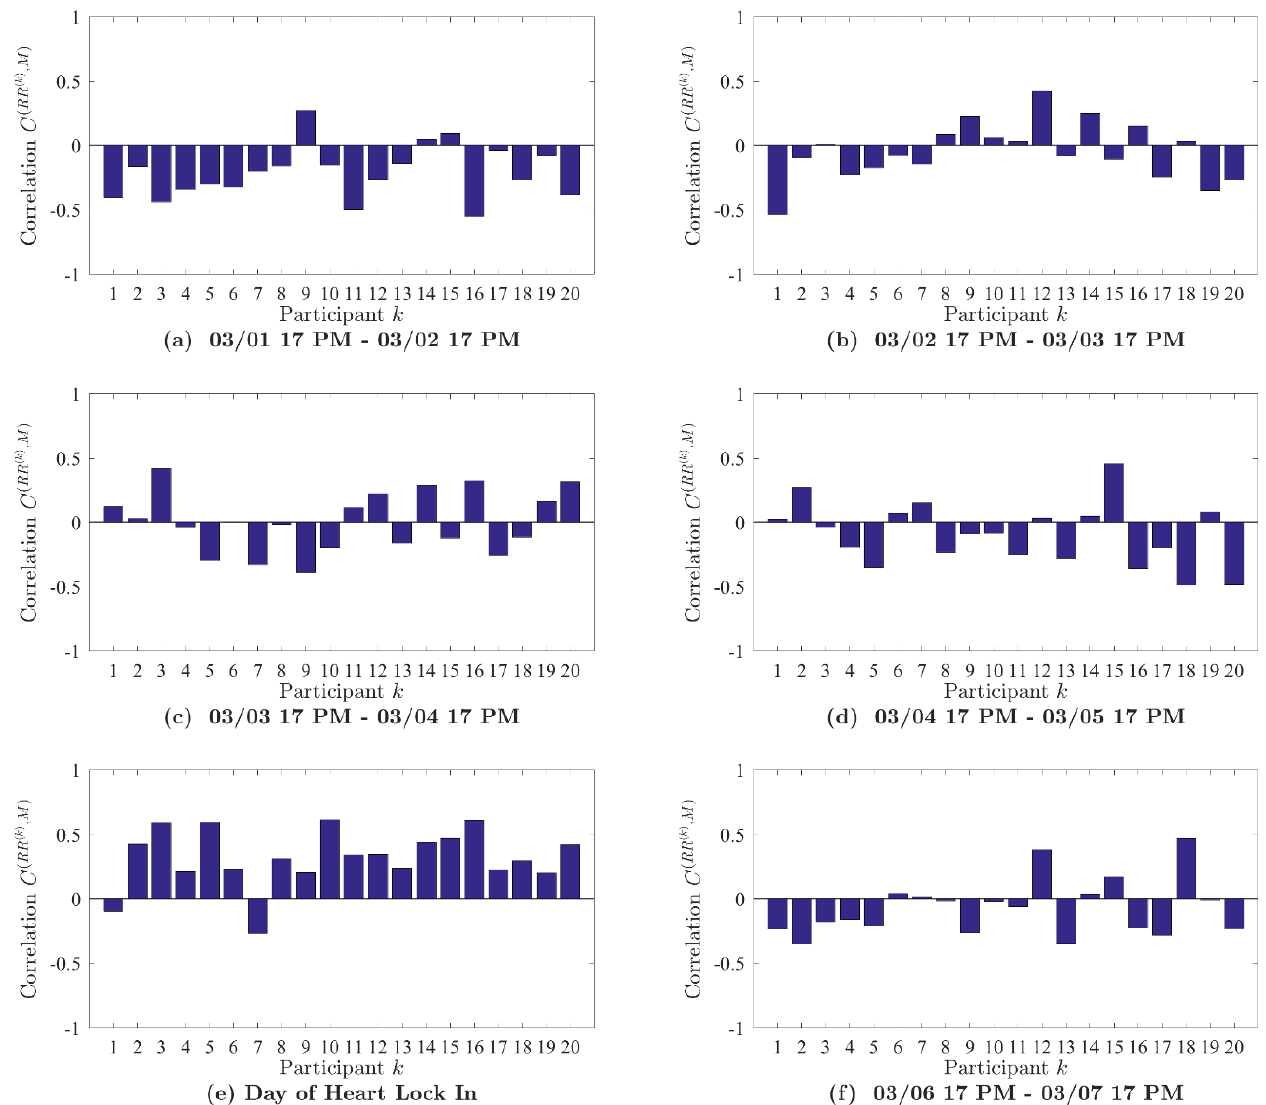
Figure A2. The results of the analysis of the LMF-HRV-synchronization for Lithuania. Each part of the figure displays participants’ LMF-HRV-synchronization for the indicated day. Plot (e) corresponds to the day of the Heart Lock-In. Note that almost all of the participants’ HRV signals shifted to being positively correlated (synchronized) with LMF, and the highest LMF-HRV-synchronization values were obtained during the day of the Heart